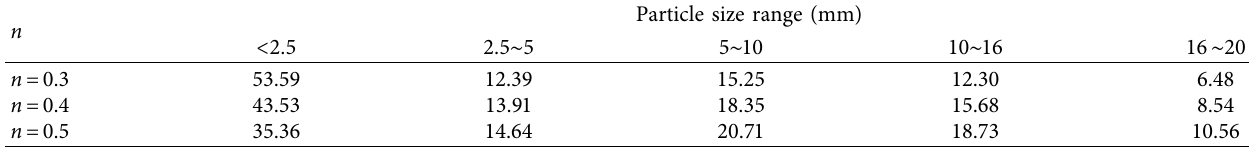
Table 1: Particle size distribution of construction waste for different Talbol gradation indexes (wt. %).